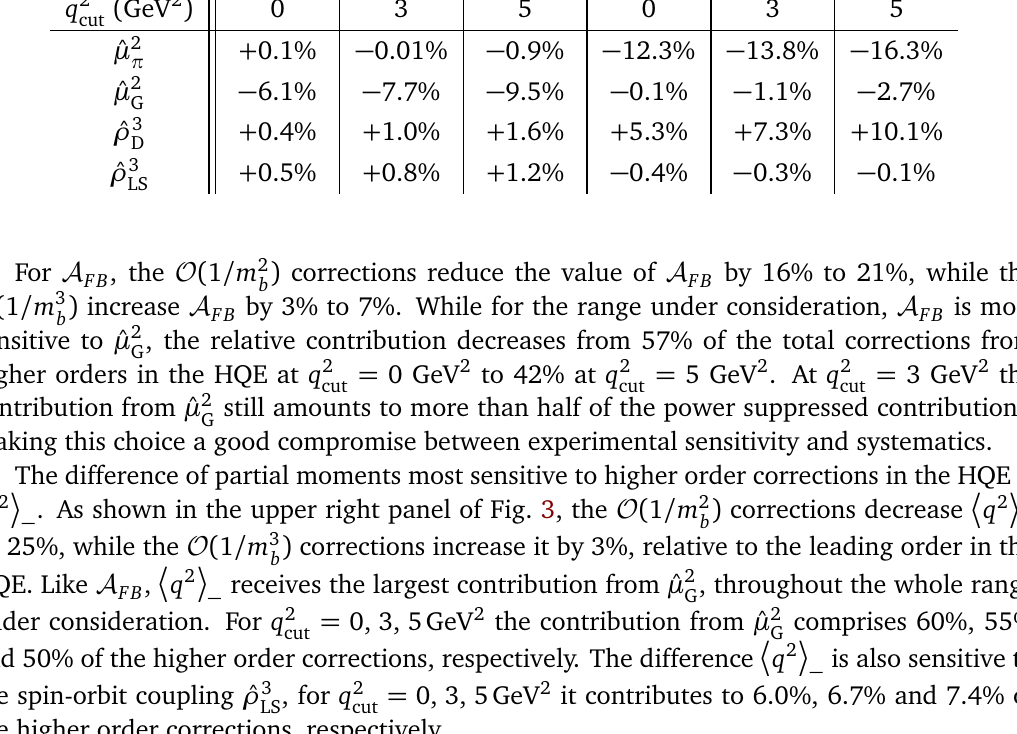
(cid:0) (cid:1) 1 / m 3 contributions to b O